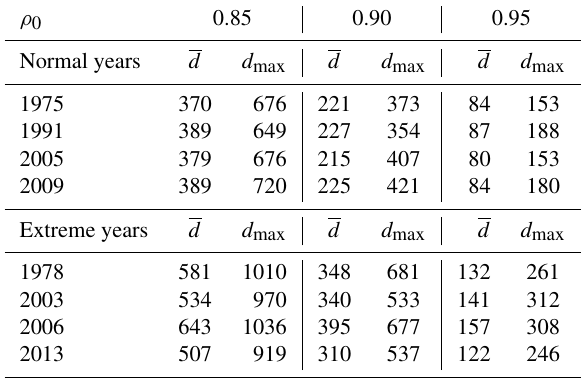
Table 2. As in Table 1 but for heatwaves in the GE region during